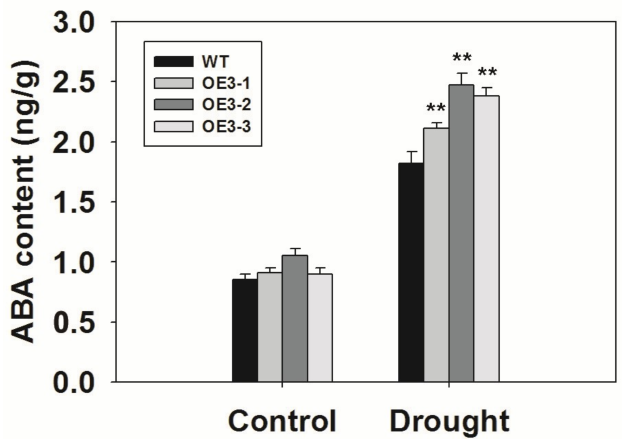
Figure 9. Overexpression of ZmASR3 increases the ABA content under drought treatment. The experiment was repeated three times with three biological replicates. Vertical bars indicate means ± S.E. ( n ≥ 3). Significant di ff erences: ** p <